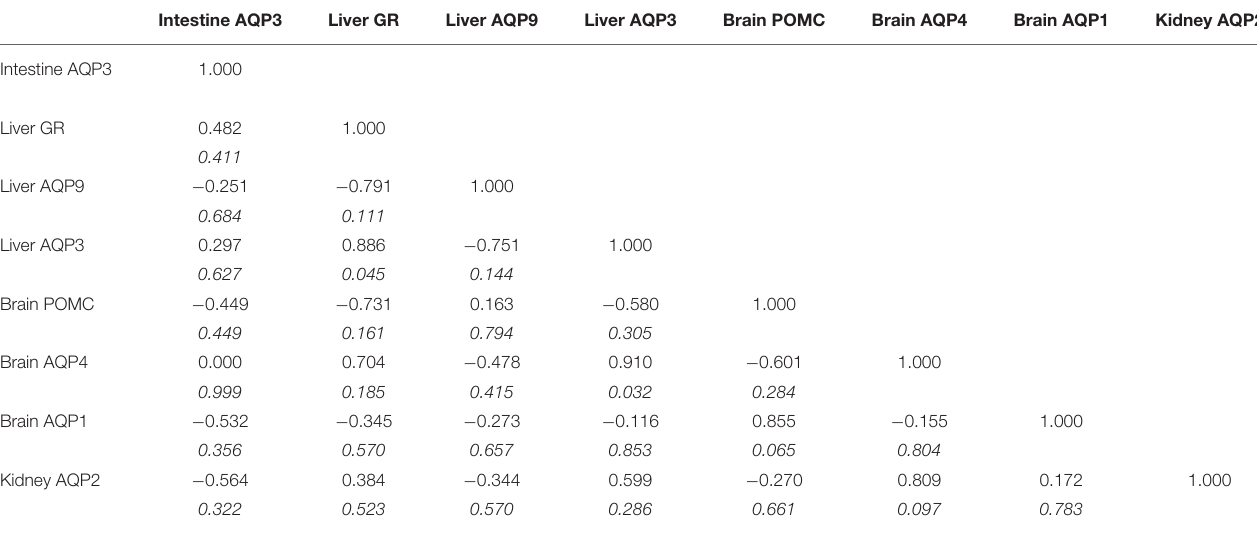
TABLE 7 | The correlation coefficient (r) between different mRNA transcripts means on Day-15 1,2 . Intestine